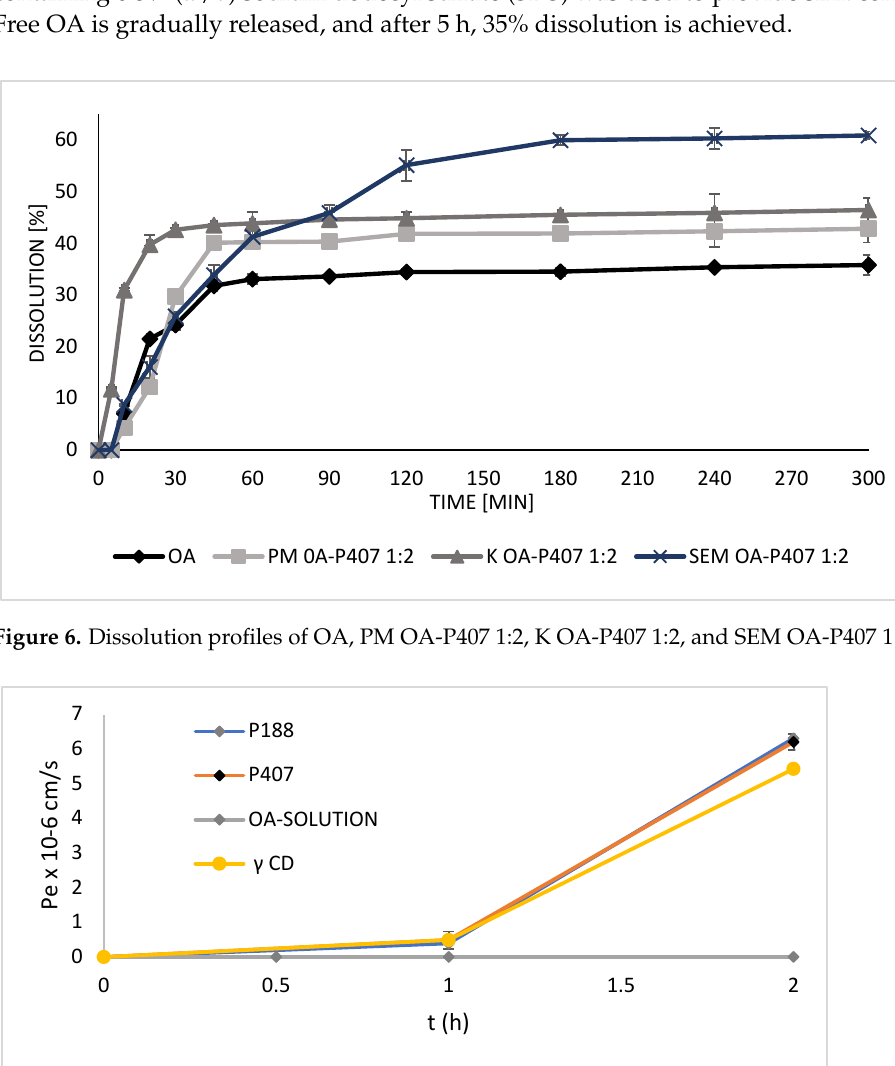
Figure 8. Schematic representation of preparation of the solid dispersions using physical mixture, kneading, and the solvent evaporation method. Moreover, P188 ameliorates the dissolution profile, obtaining 68% of the OA released in the case of SDs obtained with SEM. K and PM have the same effect, with about 50% of release at the end of the test (Supplementary Materials, Figure S5). OA begins to release from γ -CD SDs after 30, 45, and 20 min for PM, K, and SEM respectively, followed by a gradual and prolonged release (Supplementary Materials, Fig- ure S6). At the end of the test, the maximum dissolution percentage of the PM is 25%, compared to 48% for K and 49% for SEM. For all three polymers, SEM provides a close drug-to-polymer interaction, which re- sults in an improved OA dissolution profile with a higher percentage of OA in solution. This is because, in the SD system, OA uniformly dispersed in the polymer has improved wettability and dispersibility, and its crystalline state changes into a more soluble form, increasing its dissolution rate [15,17,18,34].